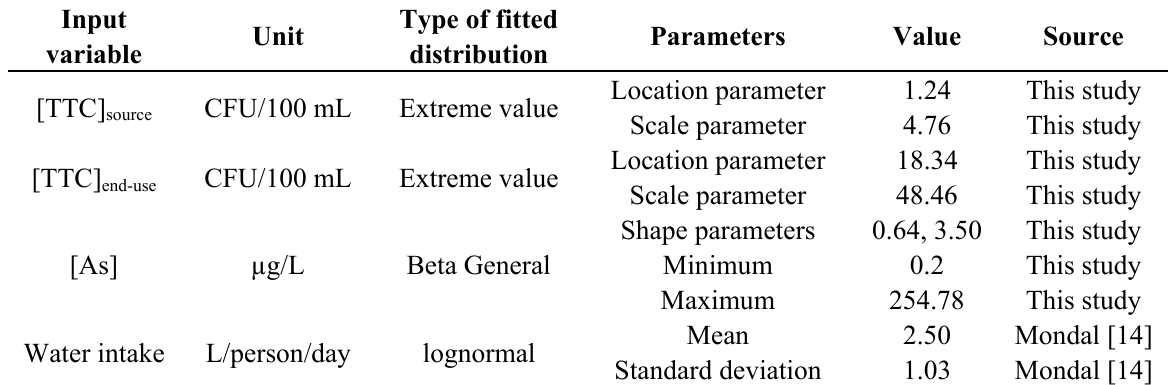
Table 6. Input parameters for DALY